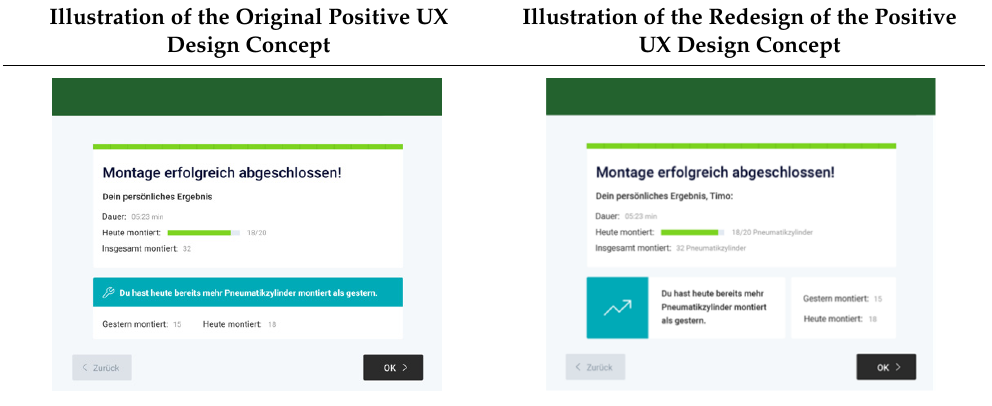
Table 7. Original positive UX design concept and respective redesign of “Personal results” and “Performance statement”.